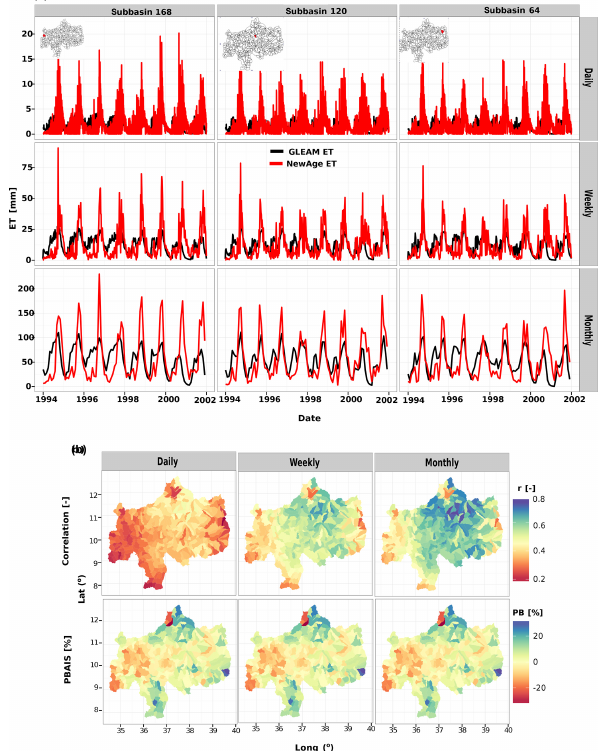
Figure 4. (a) Time series ET estimation with NewAge and GLEAM for three subbasins: subbasin ID168, subbasin ID120, and subbasin ID64 at daily, weekly, and monthly time steps. The locations of the subbasins are indicated on the maps at the top of each column of plots. (b) Spatial distribution of correlation coefficient and PBIAS between NewAge and GLEAM estimations at daily, weekly, and monthly time steps. A more detailed reading of the figure is made in the main